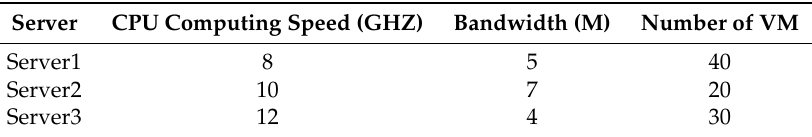
Table 2. Server performance